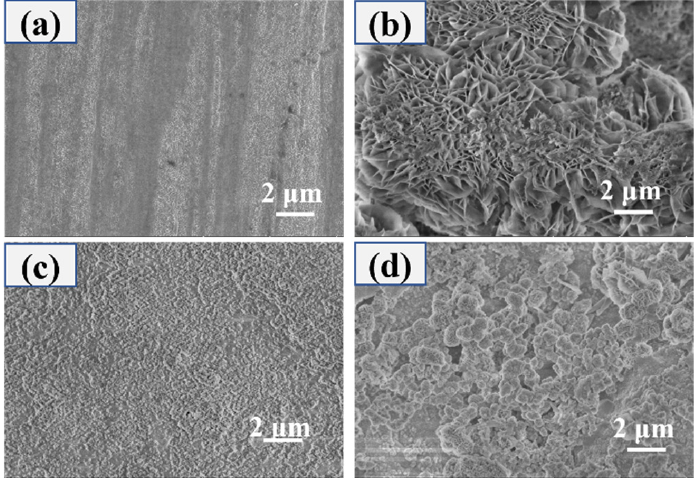
Figure 12. The surface morphology before and after the salt spray experiment ( a ) bare AZ31B Mg alloy—0 h, ( b ) bare AZ31B Mg alloy—168 h, ( c ) PVDF/SiO 2 coating—0 h, ( d ) PVDF/PFOTES-SiO 2 coating—168 h.